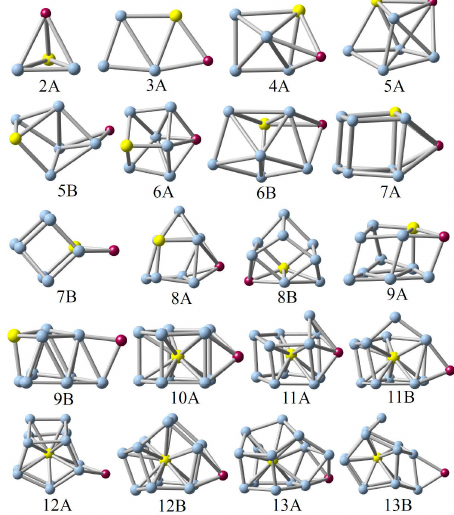
Figure 1. Low-lying structures of the AM@Ge n Au ( n = 2–13) clusters, obtained by using the hybrid B3LYP functional. The blue, yellow and purple balls represent the Ge, Au and alkali metal (AM) atoms, respectively.